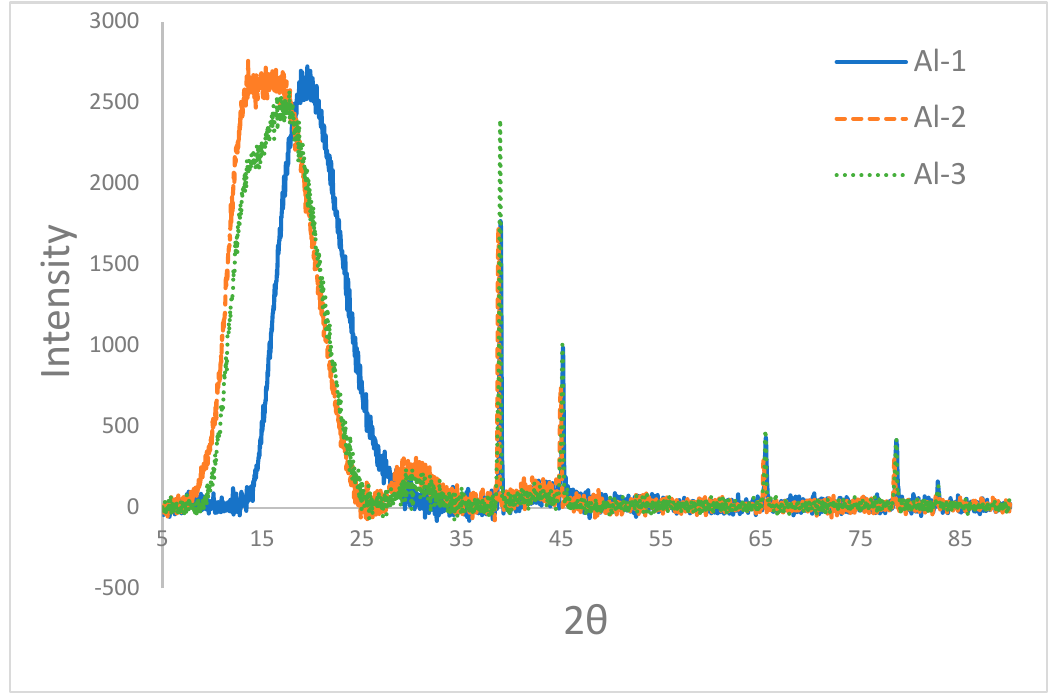
Figure 3. XRD graph for coatings prepared with the different percentages of micro Al powder.